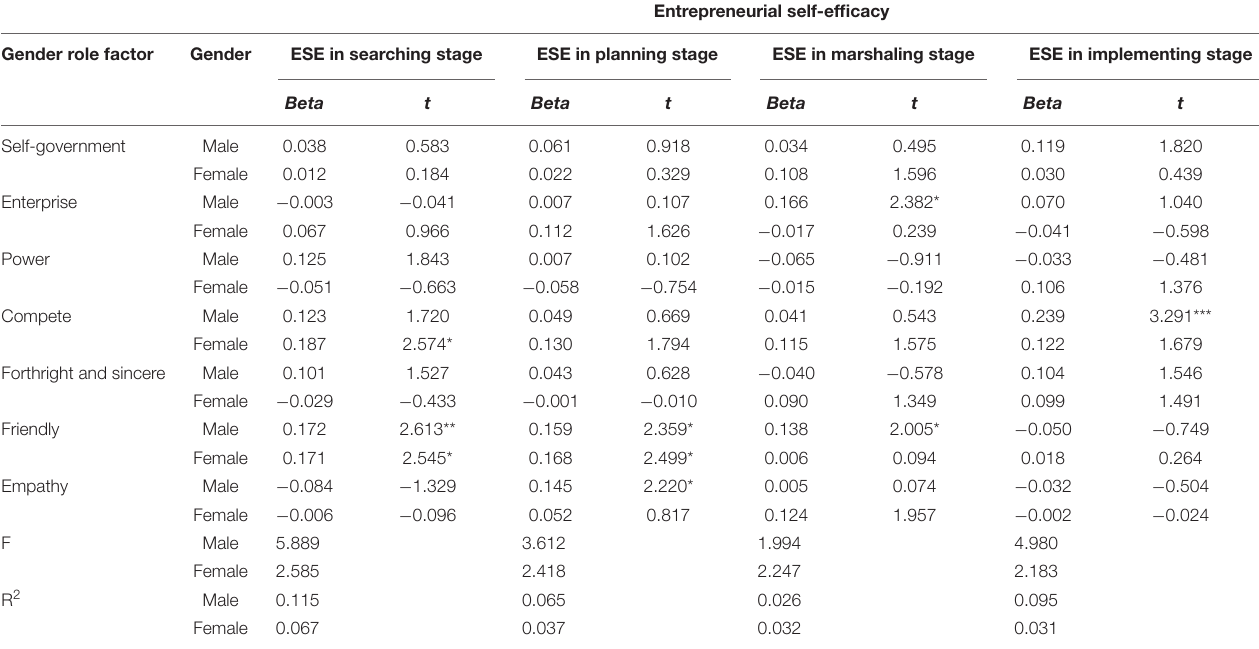
TABLE 5 | Regression